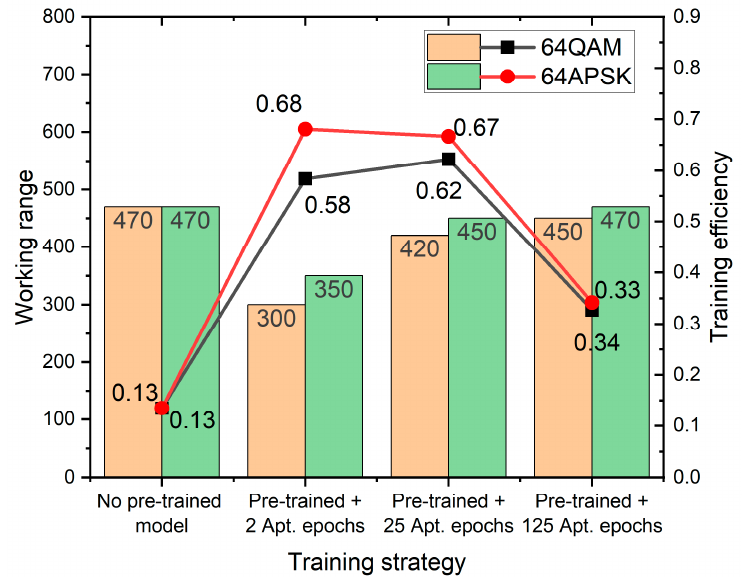
Figure 6. Working range versus training efficiency measured by the working range yield per train- ing epoch. The maximum efficiency appears either at 2 adaptive epochs or 25 adaptive epochs. The 125 epochs setting only has a marginal advantage in the working range. Figure 7 compares the difference in the loss function curve between the exhaustive training strategy and with stem model (ignoring the pre-training stage, which is close to the 650 mV group in the left diagram). It shows that all of the curves on the left consume approximately one order of magnitude of epoch number more to approach the same loss level. When training models from randomly initialized parameters, 250 mV waveform samples need about 150 epochs to make the loss function converge. However, in 650 mV and 850 mV cases, the loss function indicates that the model still does not find the mini- mum, leaving an under-fitted model. When starting from a ‘stem model’, the loss function converges quickly. In the 250 mV and 650 mV cases, at no.25 epoch, the loss functions already approach the result in exhaustively training strategy. The 850 mV case is signifi- cantly slower than the former two, and it consumes 125 epochs to reach the same level as randomly initialized models.